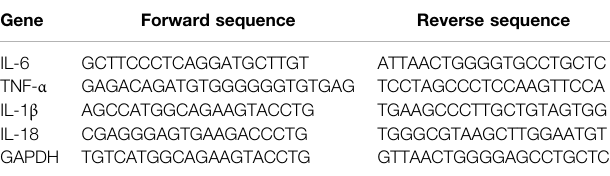
TABLE 2 | Primers used for human LO2